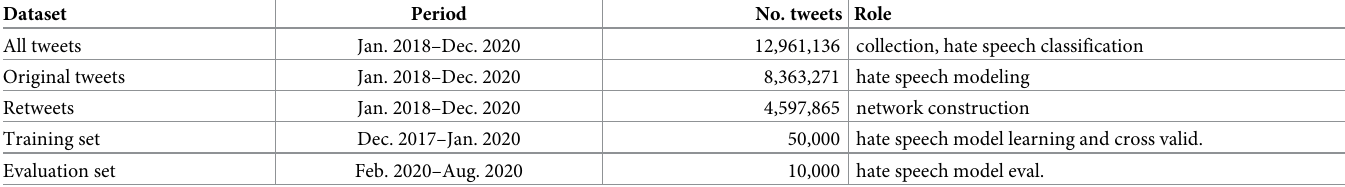
Table 1. Slovenian Twitter datasets used in this paper. Out of almost 13 million tweets collected, a selection of original tweets is used for hate speech annotation, training of classification models, and their evaluation. The retweets are used to create retweet networks, detect communities and influential users. Dataset